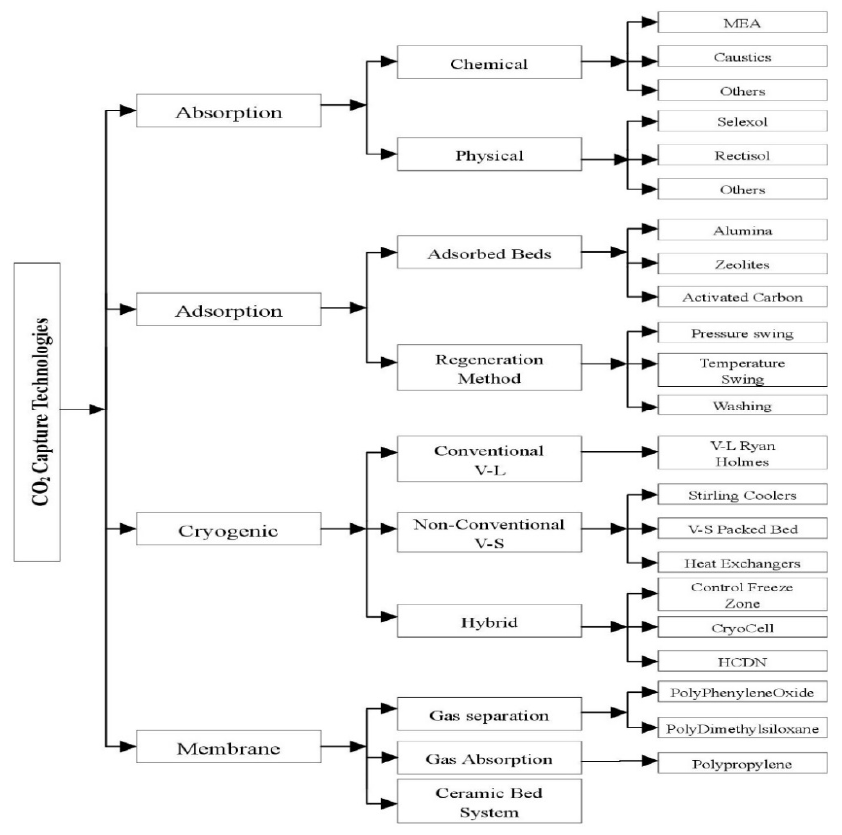
Figure 1. CO 2 capture technologies. With permission from Ref. [17]. Copyright 2020,